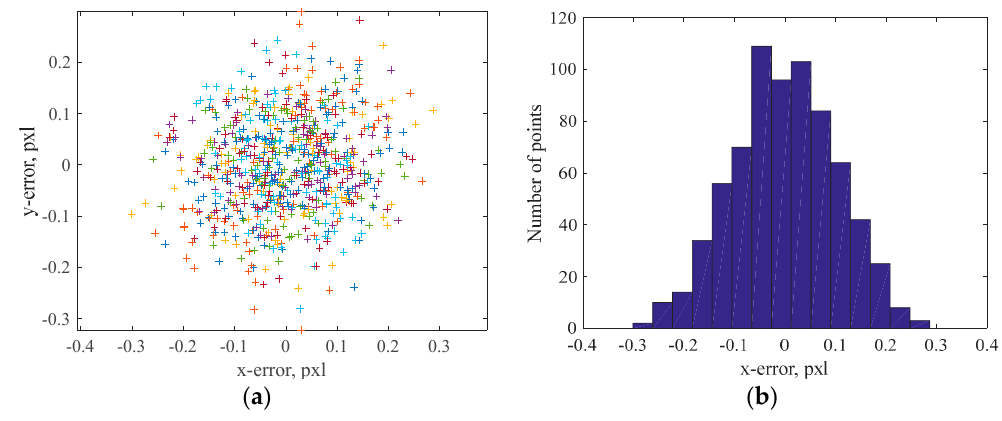
Figure 7. Re-projection errors after the optimization process: ( a ) 2D overview and ( b ) x-error histogram.